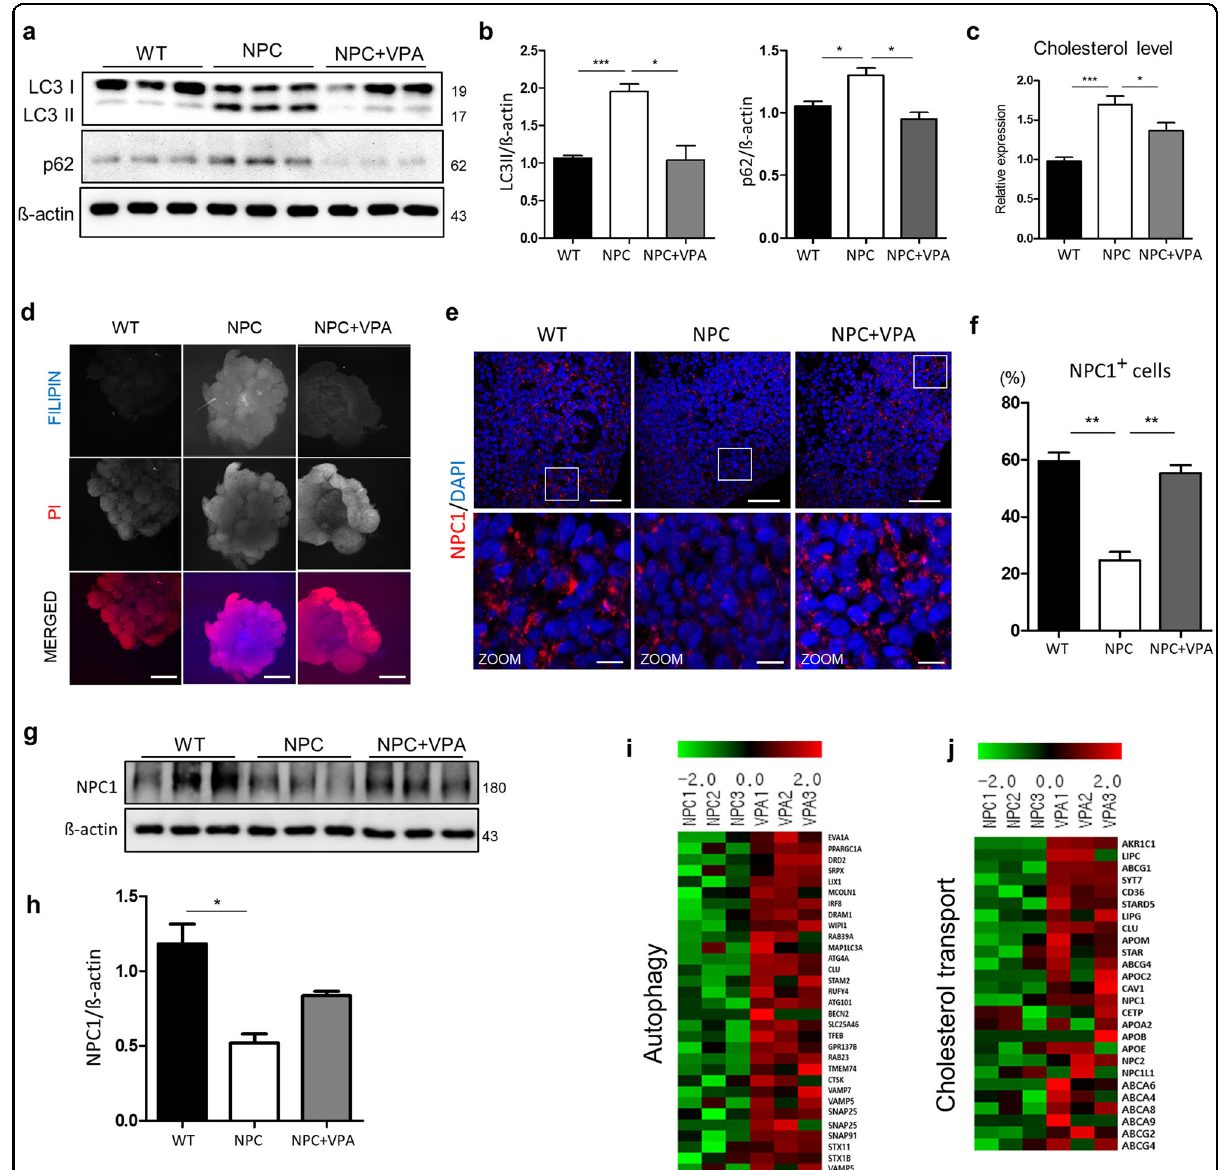
Fig. 7 The therapeutic effect of VPA is dependent on autophagic signaling. a Western blot analysis and b quanti fi cation of the LC3-II and p62 levels in the WT, NPC, and VPA-treated NPC organoids. n = 3 per group. c Cholesterol levels in each organoid were quanti fi ed and normalized to those in the WT organoids. n = 10 per group. d Whole-mount fi lipin staining of the WT, NPC, and VPA-treated NPC organoids on day 28. Scale bars, 500 μ m. e Immunostaining for NPC1 in the WT, NPC, and VPA-treated organoids. f Quanti fi cation of NPC1 staining in each group. Scale bars, 50 μ m. Zoom scale bars, 10 μ m. g Western blot analysis of NPC1 marker and h quanti fi cation of each group. n = 3 per group. i , j Heat map of the differentially expressed genes related to cholesterol transport and autophagy in the NPC and VPA-treated NPC organoids. n = 3 per group. * p < 0.05 and *** p < 0.001. The results are the mean ±